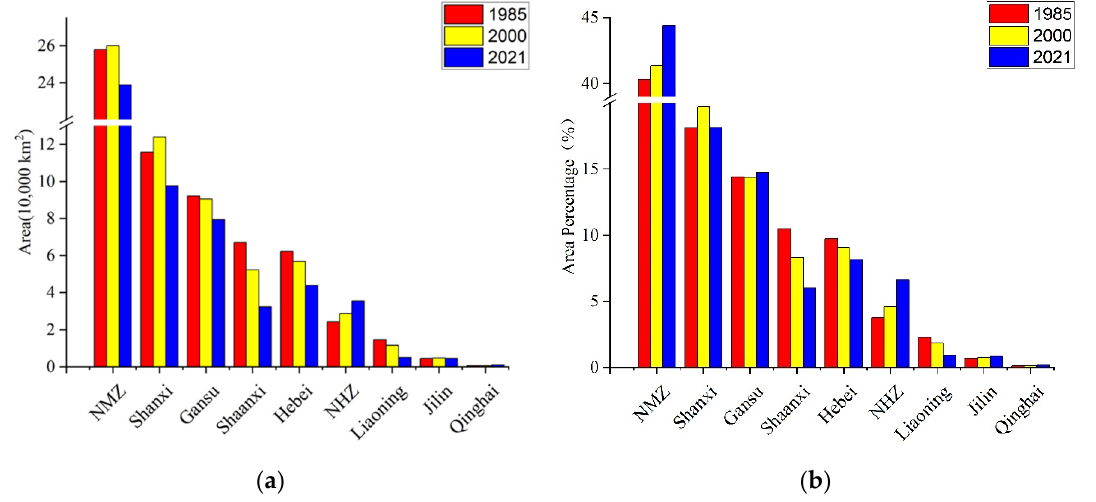
Figure 3. Area and area proportion of FPE in different provinces. ( a ) Area; ( b ) Area percentage.